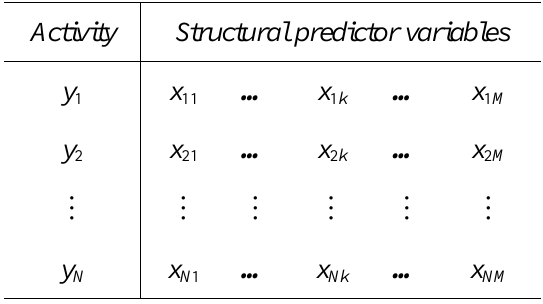
Table 1. Synopsis of the basic SAR